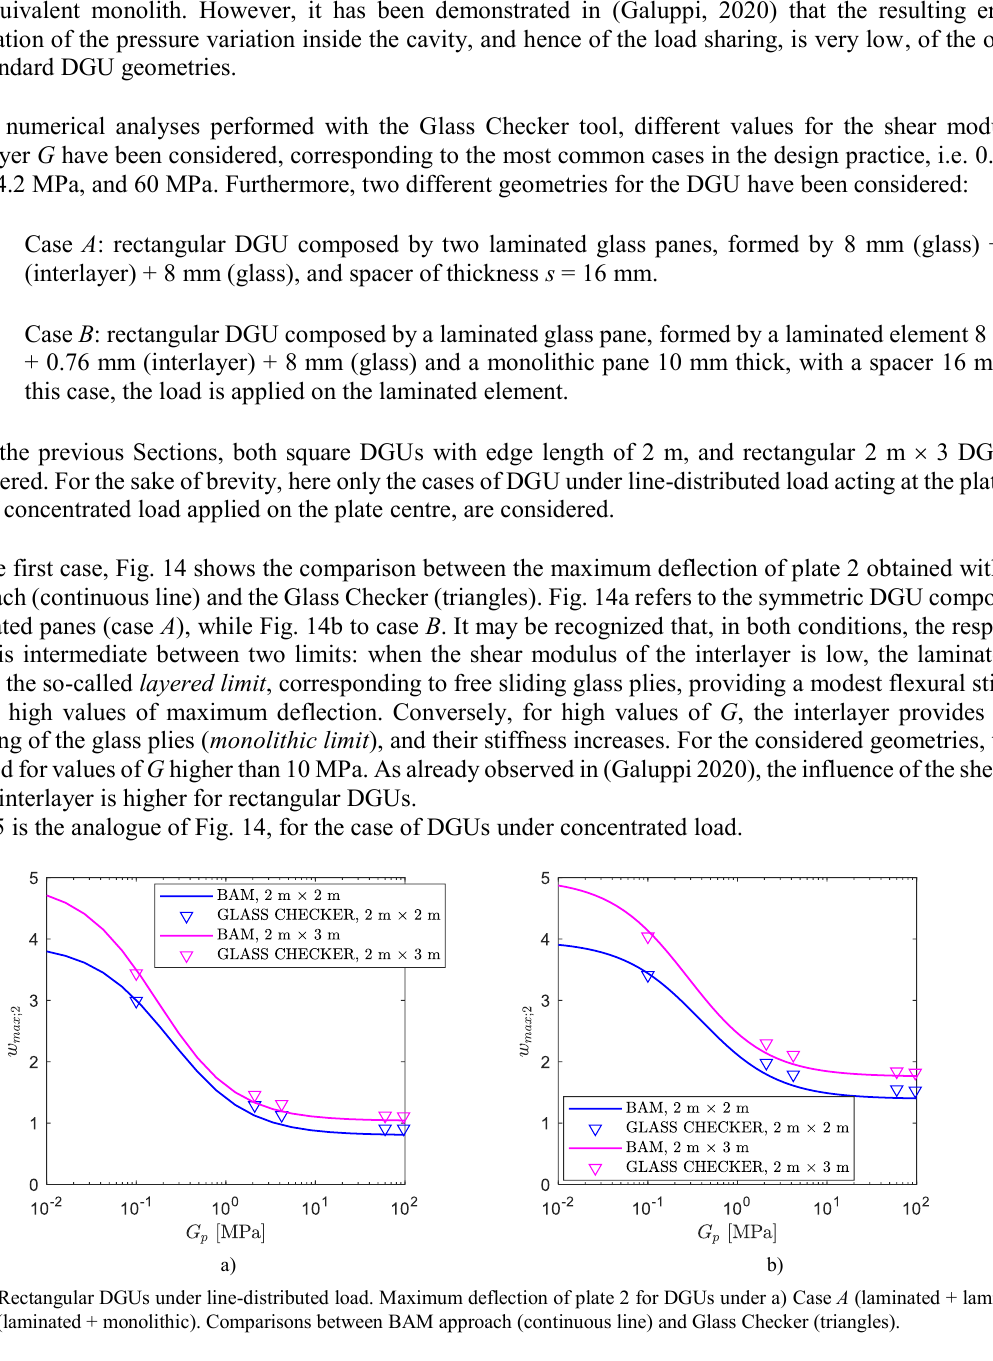
Fig. 14 Rectangular DGUs under line-distributed load. Maximum deflection of plate 2 for DGUs under a) Case A (laminated + laminated) and b) Case B (laminated + monolithic). Comparisons between BAM approach (continuous line) and Glass Checker (triangles).